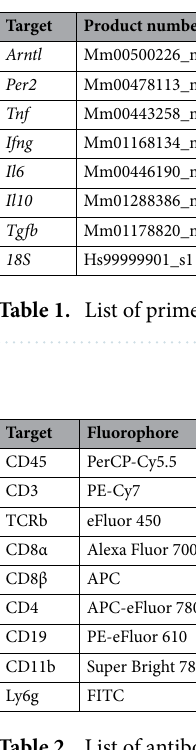
Table 2. List of